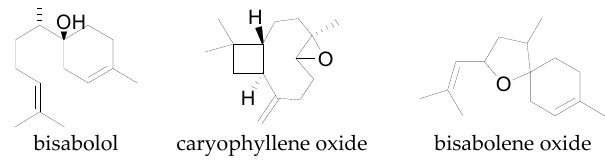
Figure 6. Chemical structures of some sesquiterpenes in cotton.